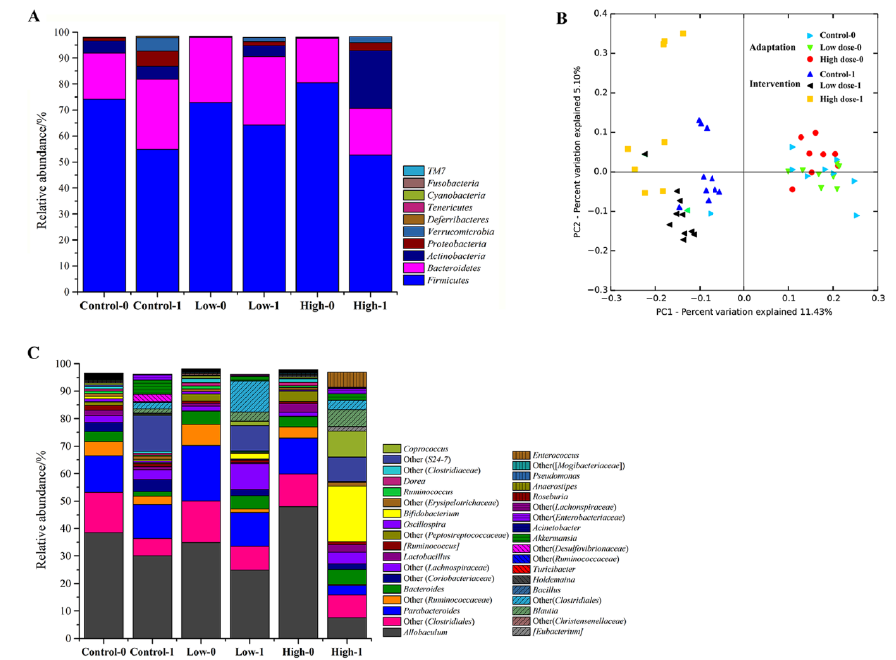
Figure 3. Changes of the composition of fecal microbiota for the two FOS diets. Bacterial diversity at the phylum level ( A ) and genus level ( C ). Principal coordinate analysis (PCoA) score plots based on unweighted UniFrac metrics ( B ), where each point represents the composition of the fecal microbiota of one mouse. “0” stands for before FOS intervention and “1” stands for after FOS intervention.